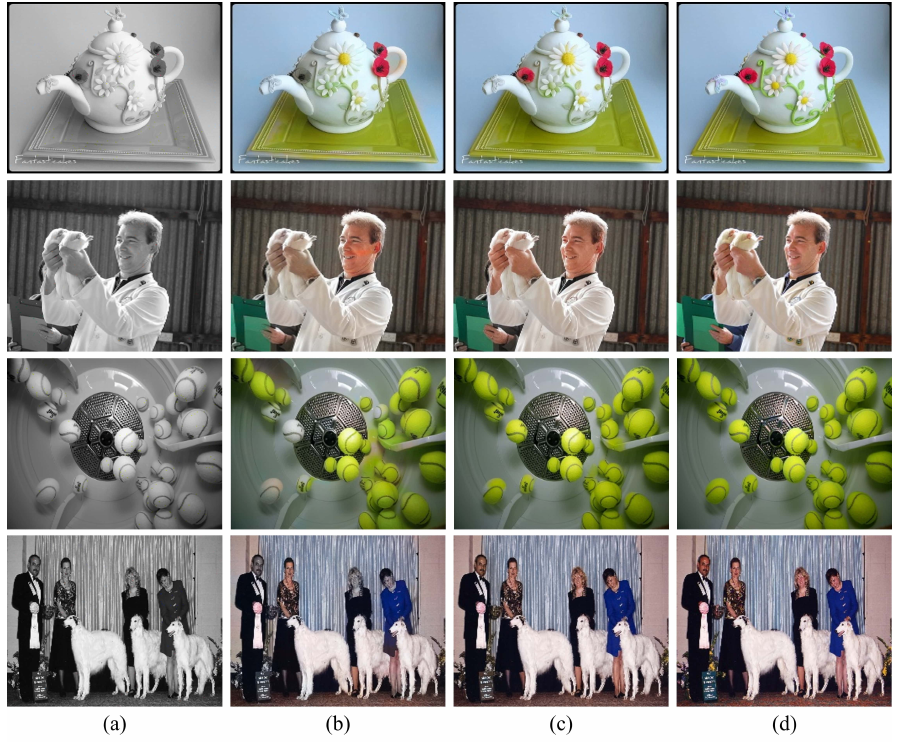
Figure 8. Visual comparison of the effect of long-range dependency on hint-based image colorization. ( a ) Input luminance and color hints. ( b ) Result of Zhang’s CNN model [7]. ( c ) Result of the proposed HCoTnet model. ( d ) Ground